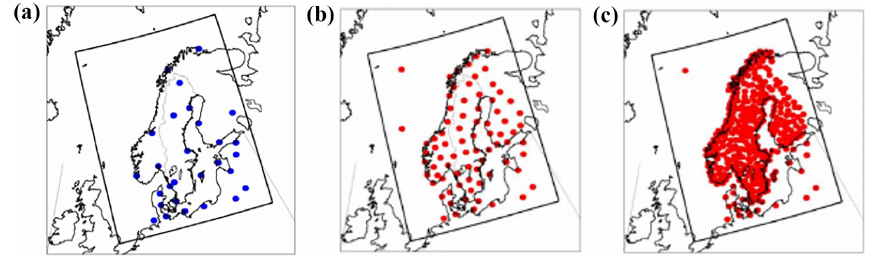
Figure 4. MetCoOp model domain (black frame) and GNSS ZTD observation usage for operational MetCoOp (a) , NGAA usage with 80–100km thinning distance (b) and NGAA usage with 40km thinning distance (c)